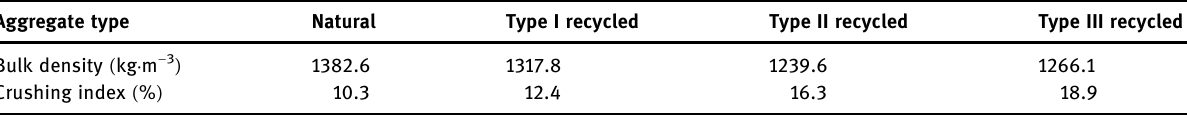
Table 6: Performance indicators of coarse recycled